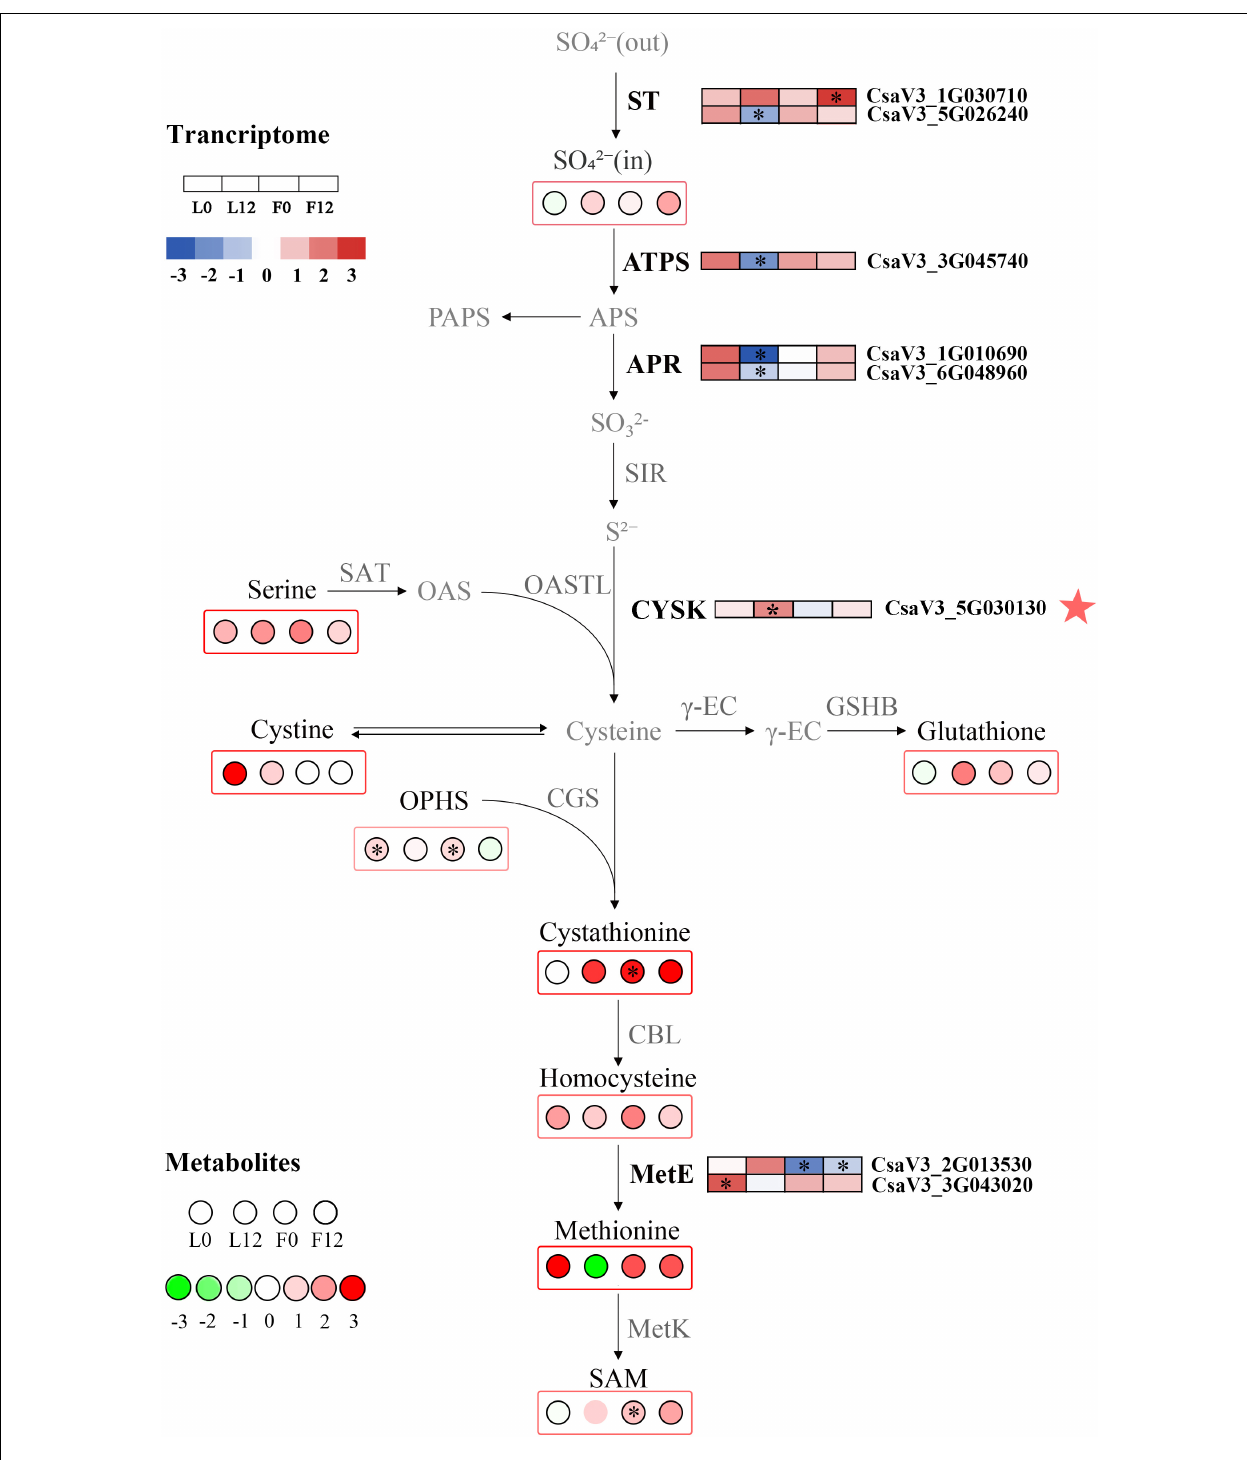
FIGURE 9 | Changes in S metabolism in S fumigated cucumber. Upregulated and downregulated genes and metabolites due to S fumigation are represented by blue-to-red boxes and green-to-red circles, respectively. The white boxes or circles represent unchanged genes or metabolites. ∗ indicates DEGs or DEMs with | log 2 FoldChange| > 1 and P -value < 0.05, or VIP > 1 and P -value < 0.05. ST, sulfate transporters; ATPS, ATP sulfurylase; APR, adenosine phosphosulphate reductase; SIR, sulfate reductase; OASTL, O-acetylserine (thiol) lyase; SAT, serine acetyltransferase; CYSK, cysteine synthase; γ -EC, γ -glutamylcysteine synthetase; GSHB, glutathione synthetase; CGS, cystathionine γ -synthase; CBL, cysteine-S-conjugate β -lyase; MetE, L -glutamine-4-(methylsulfanyl)-2-oxobutanoate aminotransferase; MetK, S-adenosylmethionine synthetase. The red star represents the hub gene identified by WGCNA.